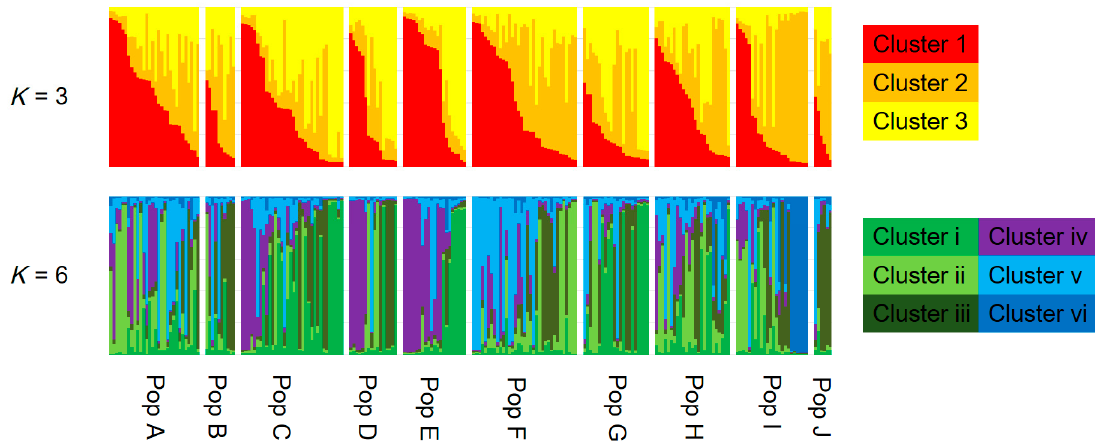
Figure 3. Assignment of each genotype (vertical bar) to genetic clusters 1, 2, and 3 in K =3, and clusters i, ii, iii, iv, v, and vi in K = 6 using a model-based Bayesian clustering method (STRUCTURE ver. 2.3.2.1). The population names correspond with those presented in Table 1.